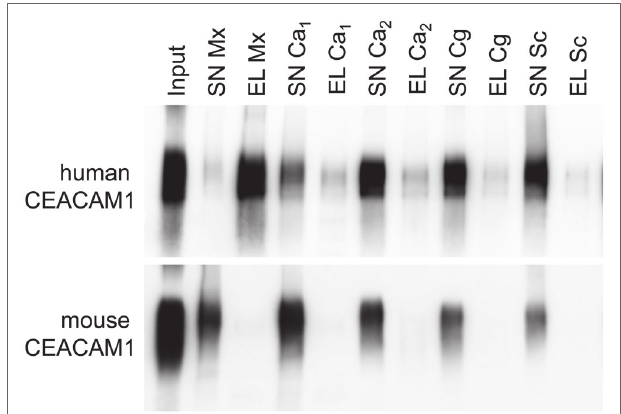
FIGURE 9 | Yeast cells display a lower affinity to human CEACAM1 than the bacterial pathogen Moraxella catarrhalis . 2 × 10 8 live yeast cells ( C. albicans SC5314, “Ca 1 ”; C. albicans 28a, “Ca 2 ”; C. glabrata 2001, “Cg”; Saccharomyces cerevisiae BY4741, “Sc”) or M. catarrhalis cells (“Mx”) were incubated with 1 μ g recombinant human CEACAM1-Fc protein or mouse CEACAM1-His protein (input). Supernatants (SN) were removed, and samples were washed twice. Bound proteins were eluted (EL), and all samples were analyzed by Western blotting for the presence of the respective recombinant protein. One representative experiment of three is shown. Note that for M. catarrhalis the majority of the human CEACAM1 protein is found in the eluted fraction, while for all yeast cells, the larger portion of the human CEACAM1 protein remains in the supernatants (upper panel). As expected, no binding was observed for mouse CEACAM1 (lower